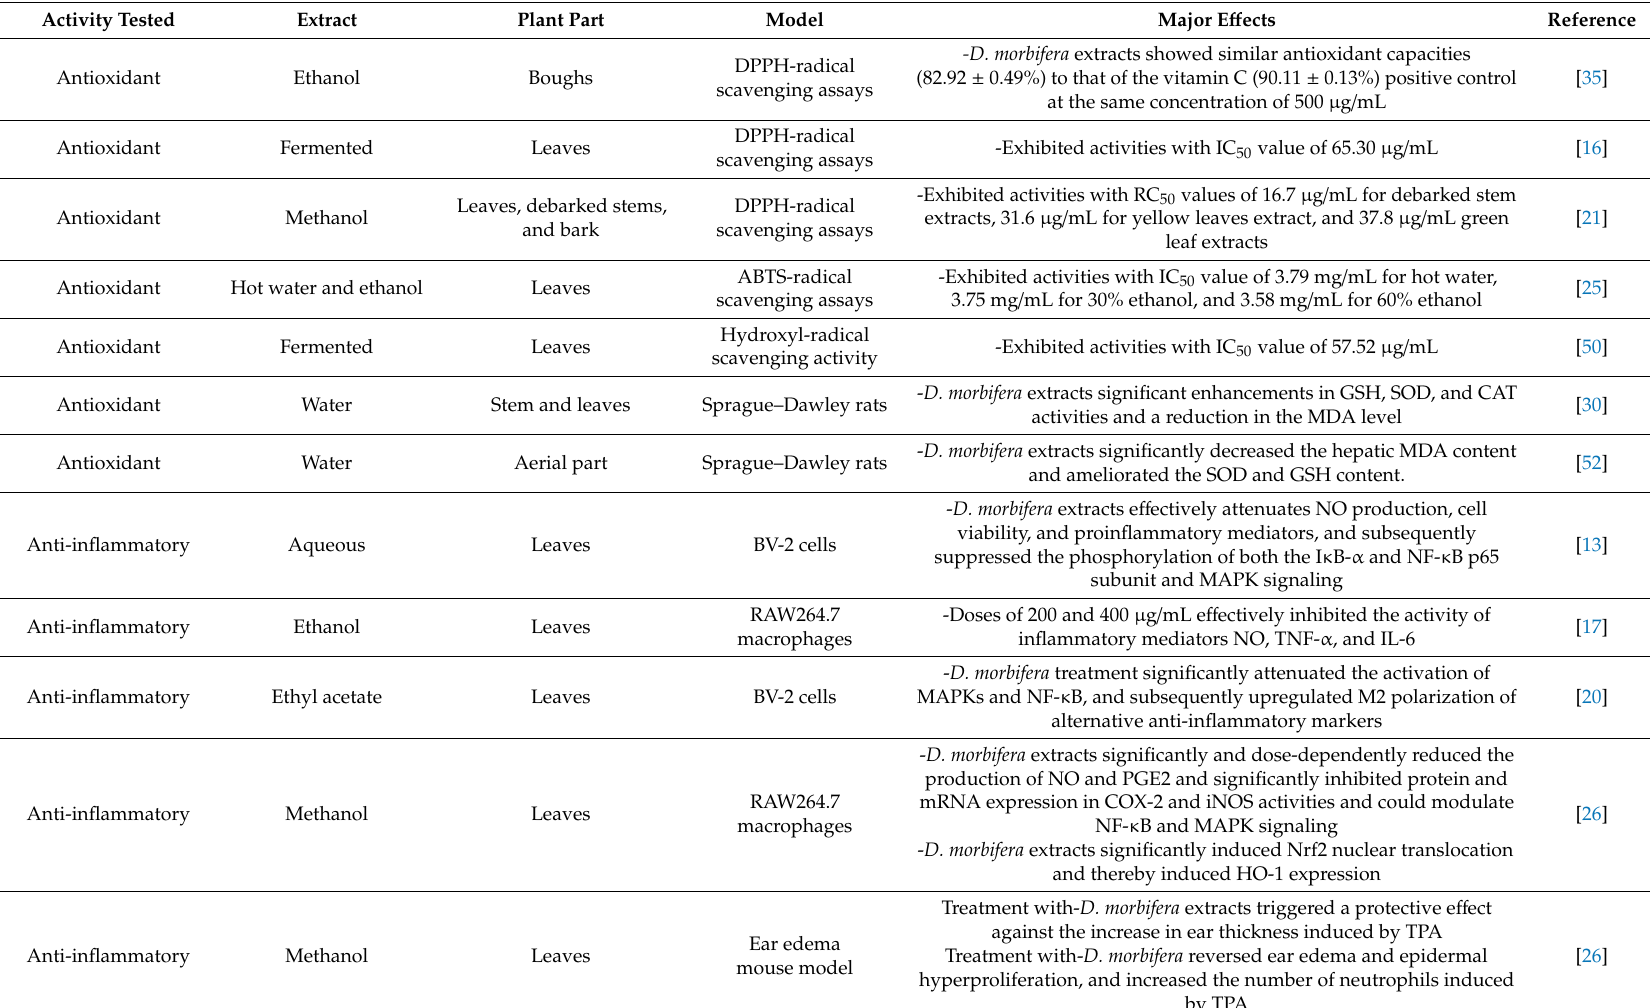
Table 3. Potential mechanisms of e ffi cacy for some pharmacologic properties of D.